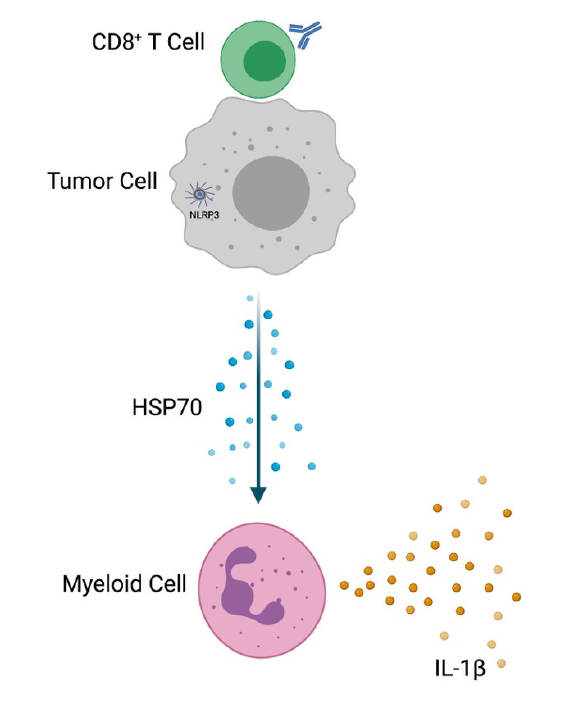
Figure 3. Tumor-intrinsic NLRP3 Inflammasome Mediates Release of HSP70 From Tumor Cells. In turn, accumulated myeloid cells, such as PMN-MDSCs, in the tumor microenvironment produce elevated levels of IL-1 β . Created with BioRender.com .